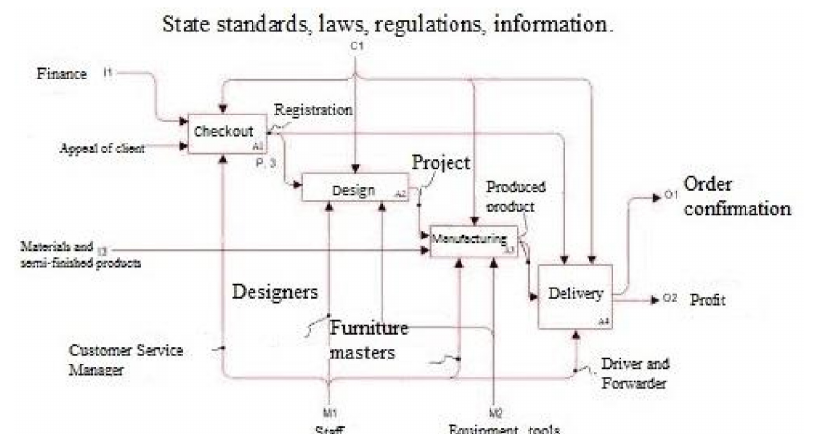
Fig. 3. IDEF0– diagram on second level